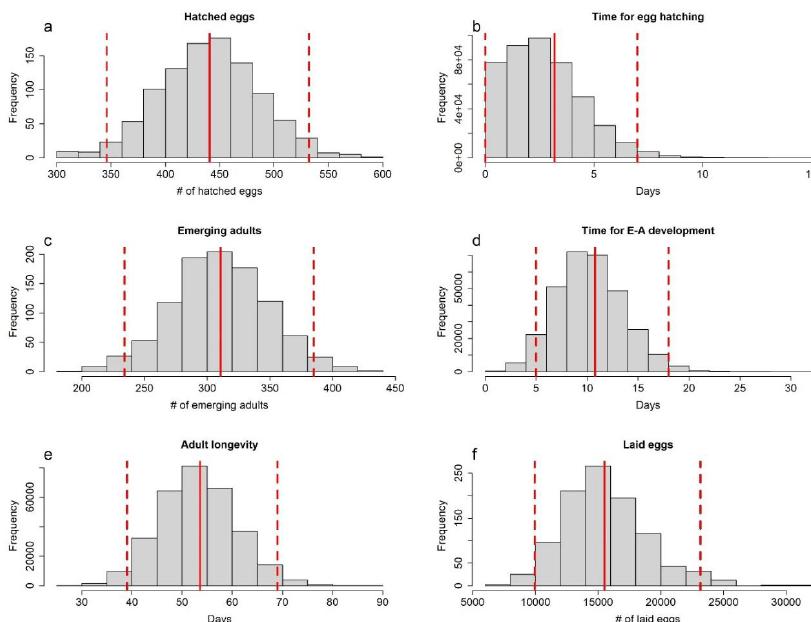
Figure A10. Distributions of quantities of interest for simulated (1000 simulations) life history of 1000 initial eggs at 30 °C. ( a ) Number of hatched eggs; ( b ) time for egg development; ( c ) number of emerging adults; ( d ) time of development from the egg stage; ( e ) adult longevity; ( f ) total number of eggs laid by all females. Dashed red lines represent the 2.5 and 97.5 quantiles, solid red lines represent the average value.